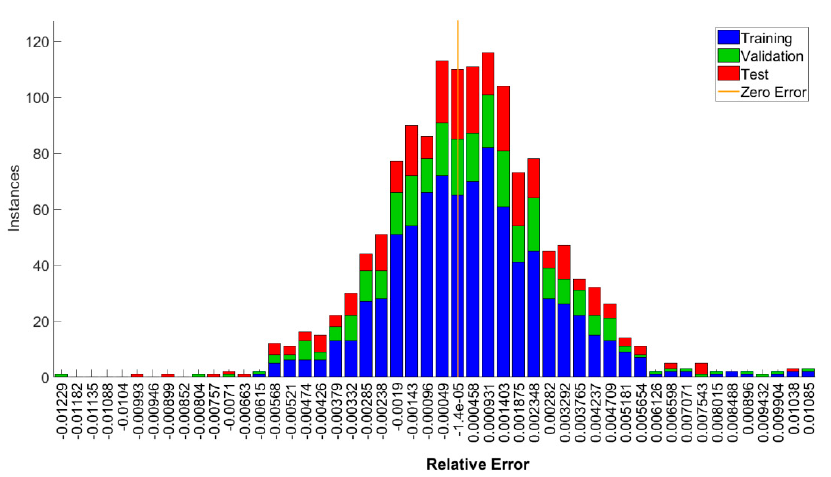
Figure 12. Relative error histograms with 50 bins obtained during the learning process for the best analyzed neural network.